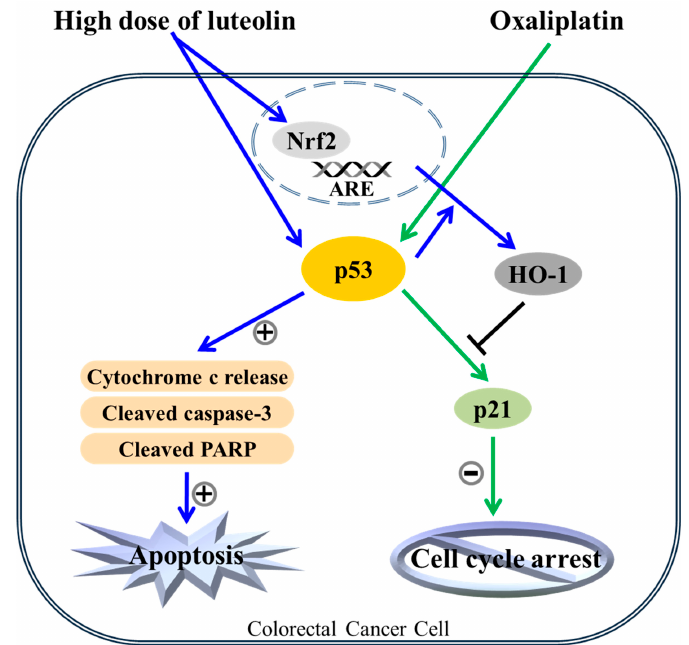
Figure 6. The apoptotic mechanism of the combinatorial treatment of luteolin and oxaliplatin. Both luteolin-induced apoptosis and oxaliplatin-induced cell cycle arrest in HCT116 human colorectal cancer cells were dependent on p53 function. Luteolin-induced apoptosis might override the oxaliplatin-induced cell cycle arrest, possibly through the increased HO-1 expression in p53-expressing cells. In addition, luteolin-induced p53-null HCT116 cell death could be intensified by oxaliplatin treatment through an unknown mechanism(s). Supplementary Materials: The following are available online at www.mdpi.com/xxx/s1, Figure S1: Cytotoxicity of oxaliplatin against p53 +/+ and p53 -/- HCT116 cells. Cells were seeded at a density of 5 × 10 3 cells per well in a 96-well plate and treated with various concentrations of oxaliplatin for 24 h. Cytotoxicity was determined by a CCK-8 assay. Data are expressed as mean ± SD of three independent experiments (*, a significant difference compared to the control group at p < 0.05).